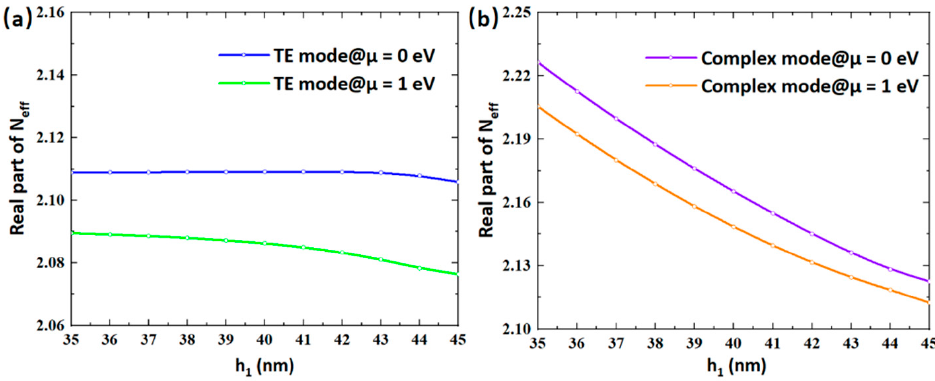
Figure 6. Re( N eff ) of ( a ) TE mode and ( b ) complex mode as a changing relationship of h 1 .